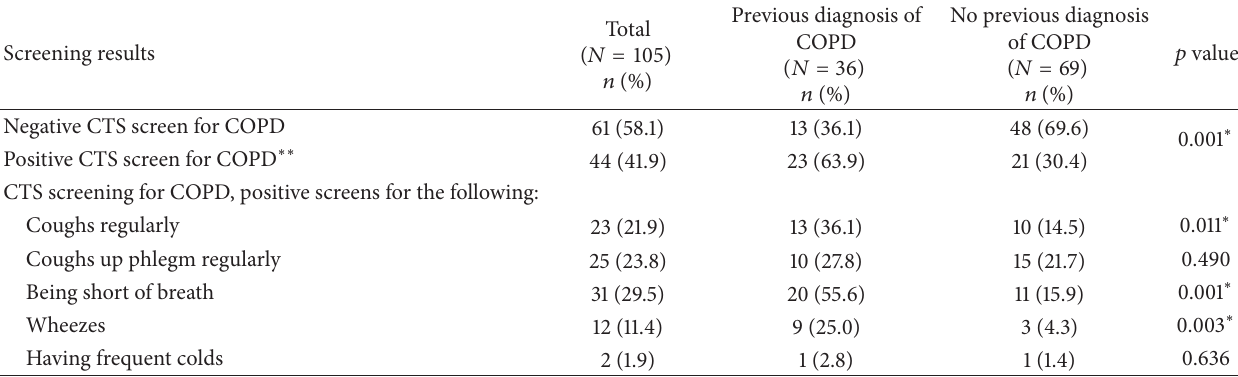
Table 3: Results of the Canadian Thoracic Society screen for COPD screen for patients with a 20-pack-year history of smoking ( 𝑁 = 105 ).